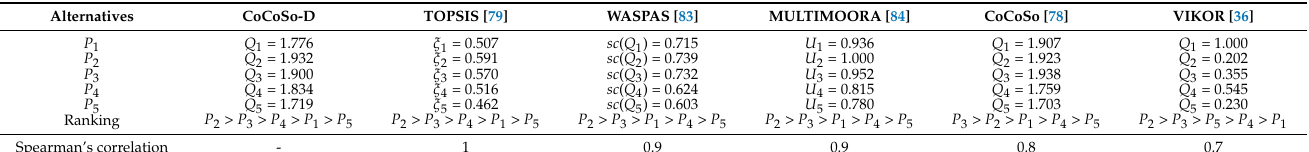
Table 12. The results of different